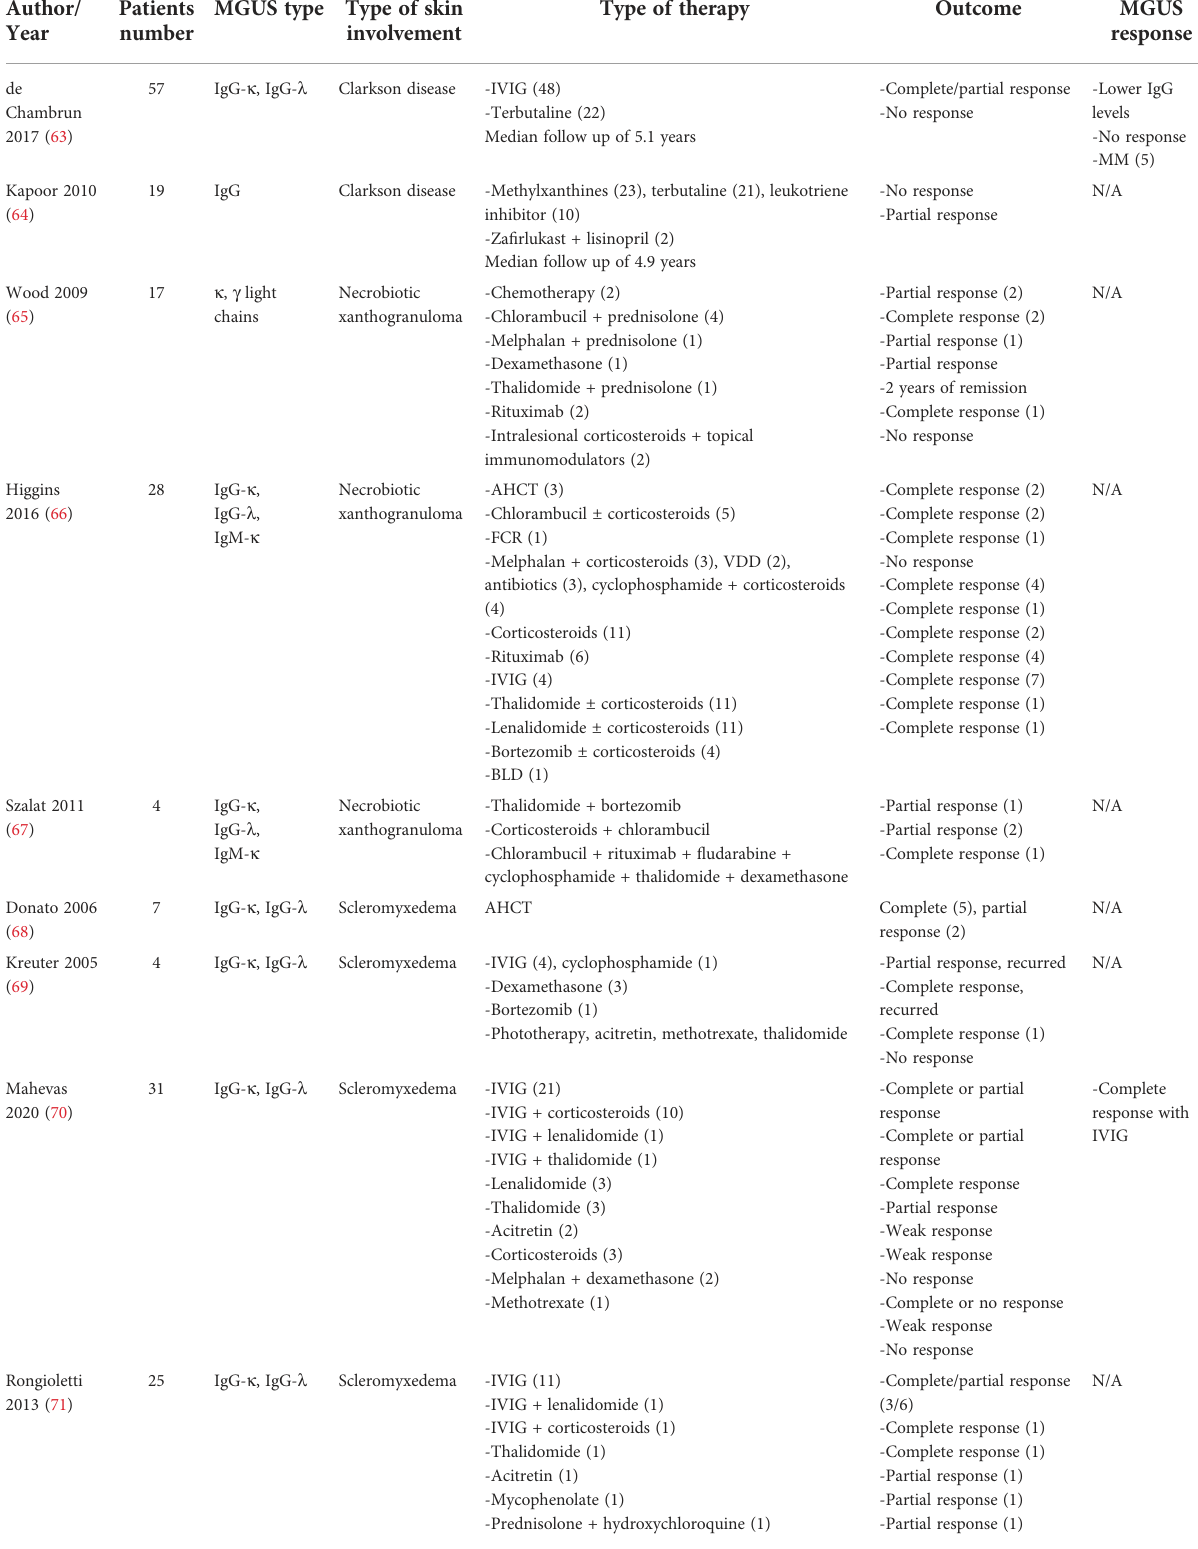
TABLE 3 Literature review of the management of MGUS-related skin